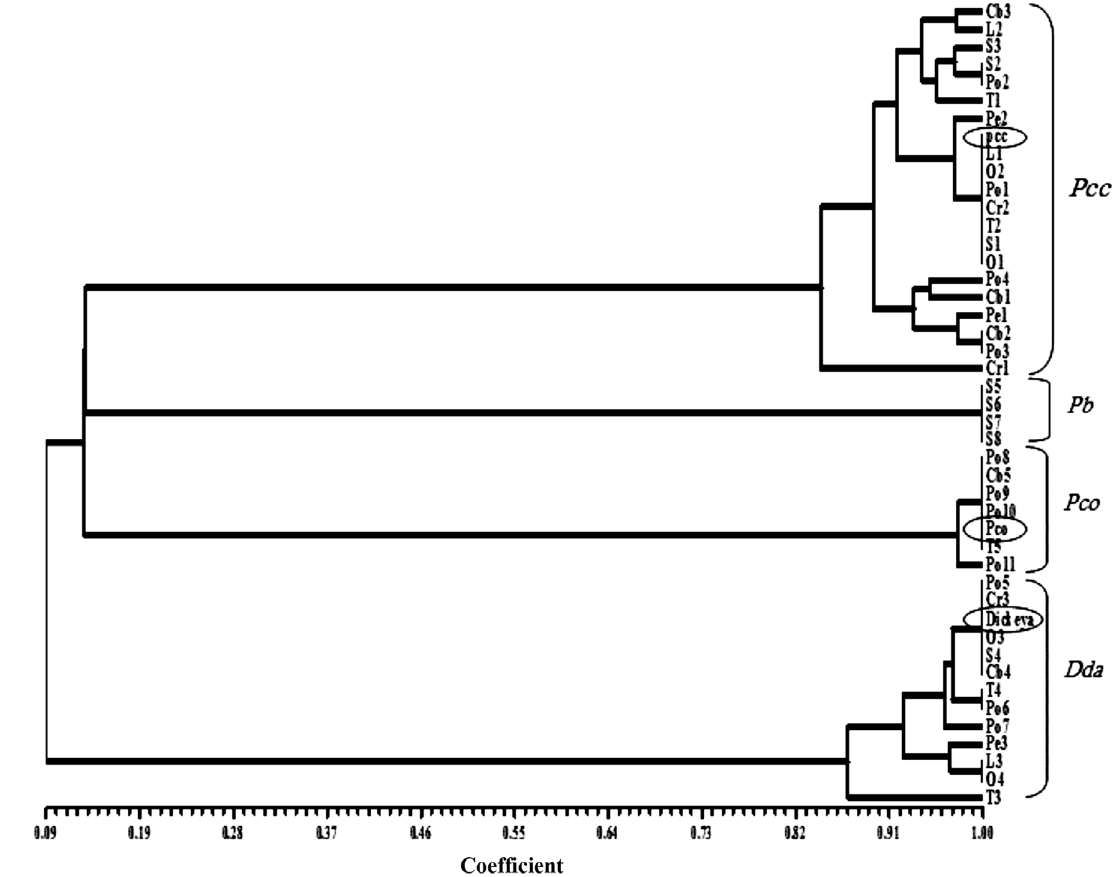
Figure 4. Dendrogram based on rep-PCR of soft rot bacteria isolates with REP, ERIC and BOX primers. Characteristics of the isolates were shown in Table 1. Dickeya , EchSCRI 3739; Pco , PcoCFBP 1878 and Figure 5. Agarose gel electrophoresis of PCR products obtained from representative strains of four distinct groups of Iranian soft rot bacteria with ERIC-